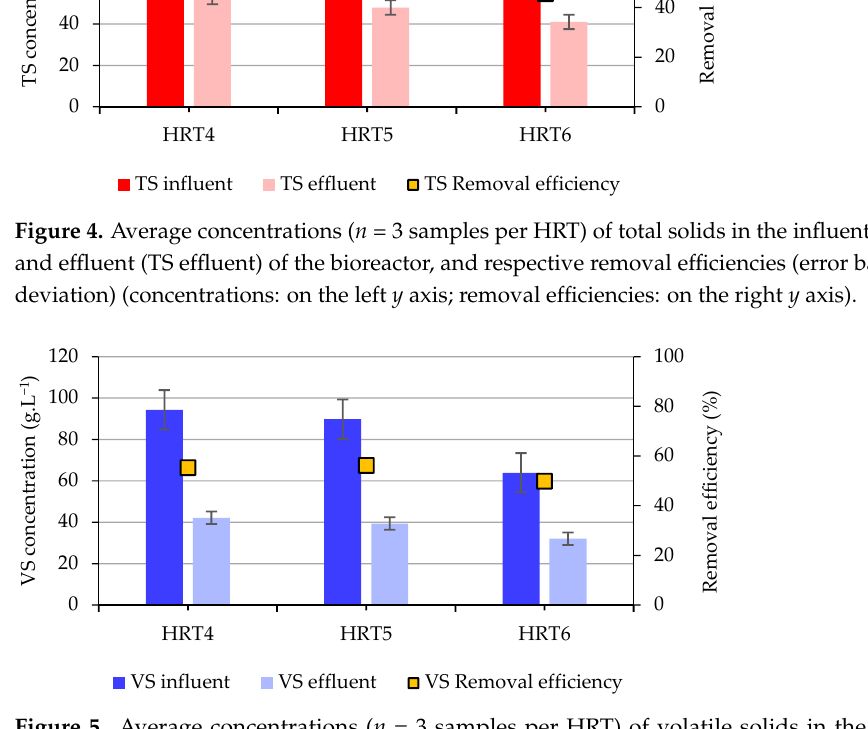
Figure 5. Average concentrations ( n = 3 samples per HRT) of volatile solids in the influent (VS influent) and effluent (VS effluent) of the bioreactor, and respective removal efficiencies (error bars: standard deviation) (concentrations: on the left y axis; removal efficiencies: on the right y axis). In the HRT4 and HRT5 assays, the TS concentrations in the influent were similar, corresponding to values of 104 and 103 g TS.L − 1 , respectively. The HRT6 assay showed an average concentration in the influent of 75.5 g TS.L − 1 , which was significantly lower